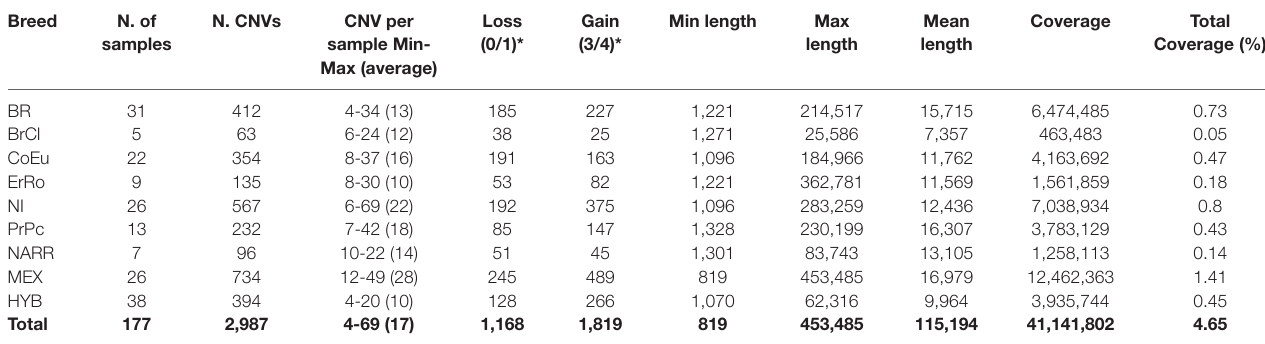
TABle 2 | Summary of CNVs identified in each population. Breed N. of